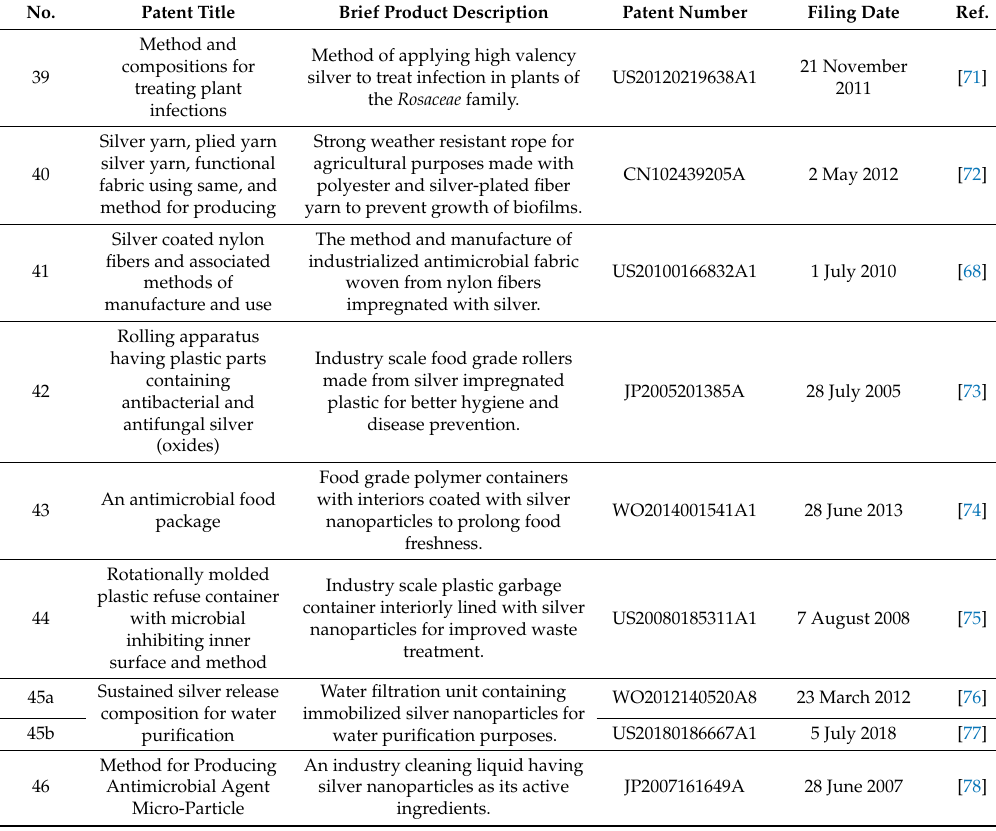
Table 4. List of patented industry and agricultural related products utilizing silver as an antimicrobial agent.